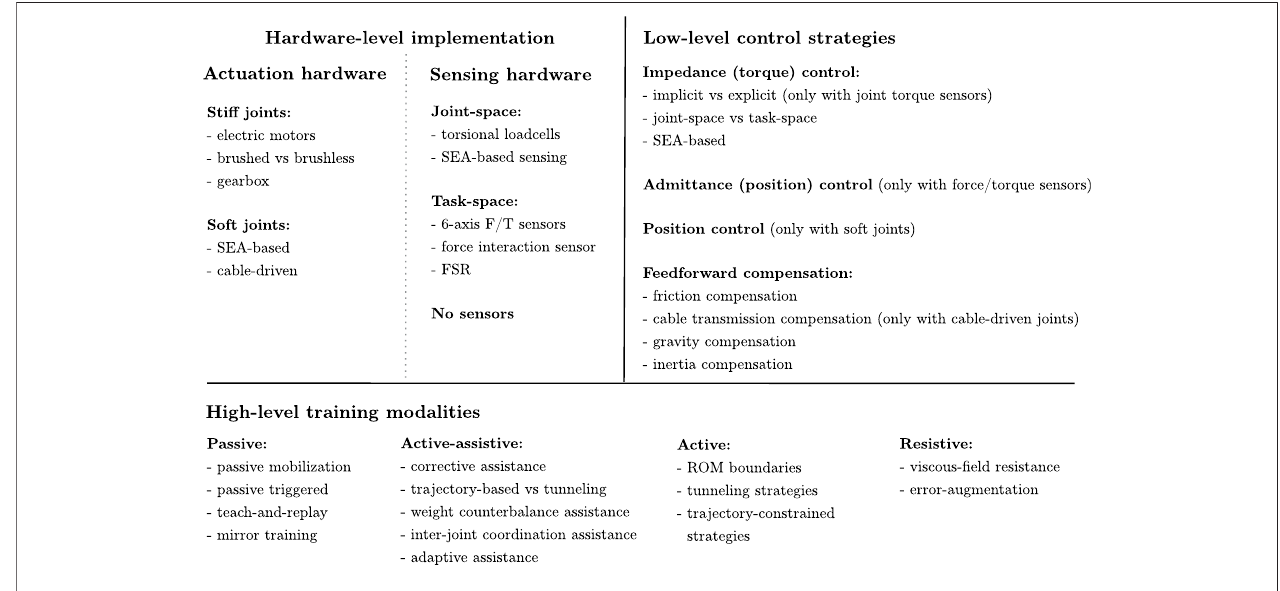
FIGURE 8 | Summary of patient-cooperative control strategies for upper-limb rehabilitation exoskeletons at different levels of implementation: hardware-level actuation and sensing implementation, low-level control strategies, and high-level training modalities.